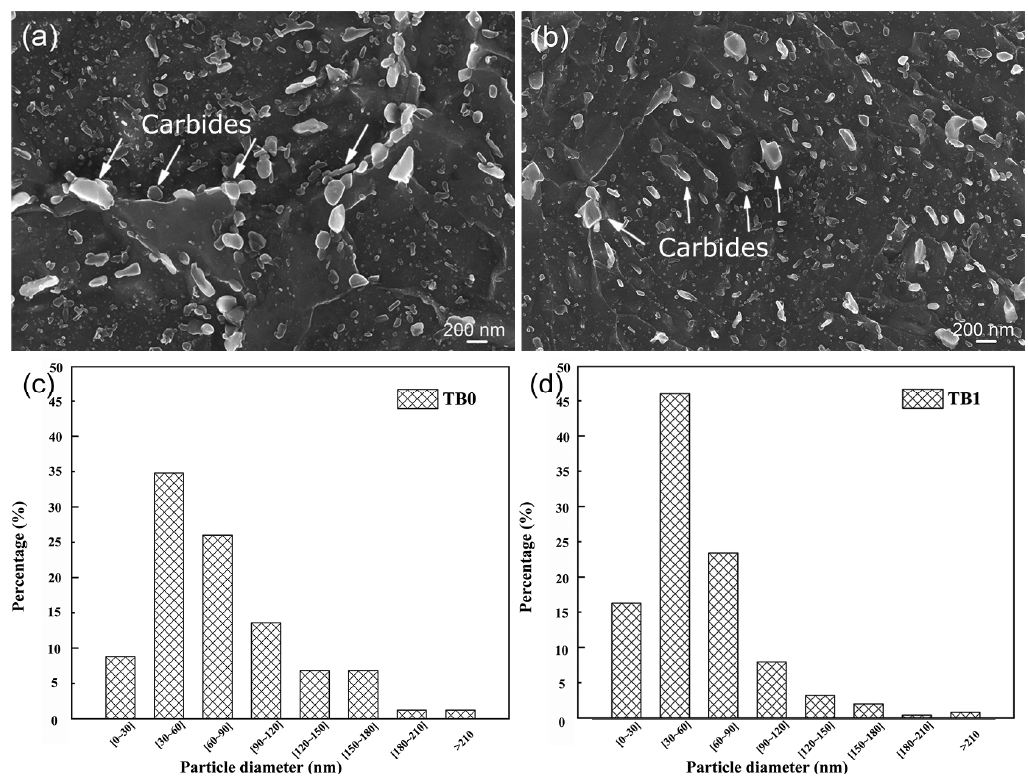
Figure 3. SEM micrographs of ( a ) TB0 and ( b ) TB1 steels after Q + T, and the corresponding carbide size distributions in ( c ) TB0 and ( d ) TB1 steels, respectively.